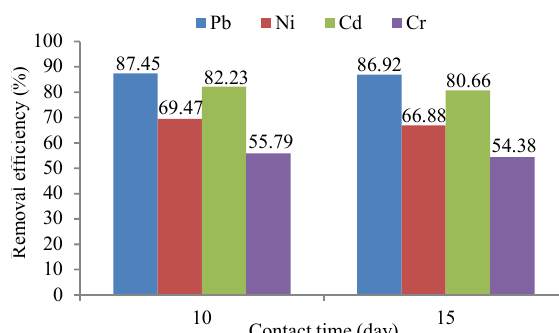
Fig. 4. Duckweed efficiency in separate heavy metal removal at concentration of 10 mg/l (duckweed weight: 0.4 g)